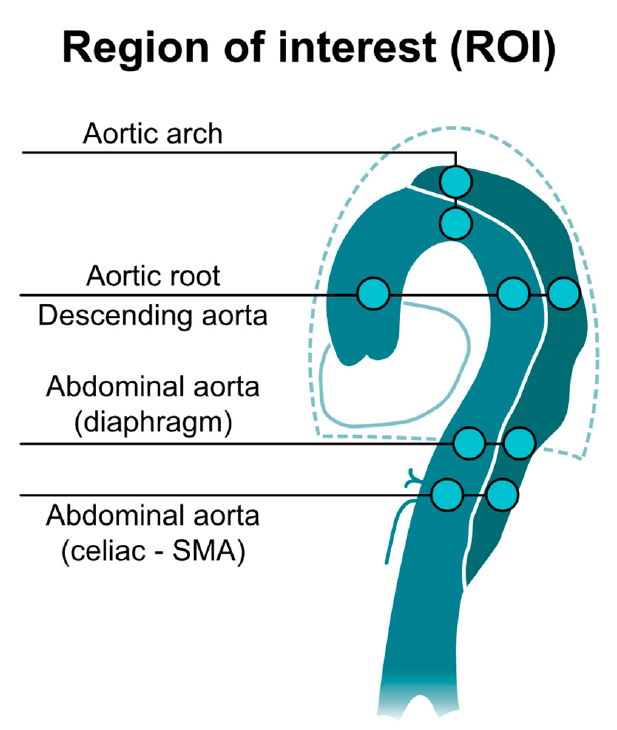
Figure 1. Illustration of QFlow scanning and drawing the region of interest (ROI). The QFlow scanning is performed at four levels to obtain two-dimensional images (perpendicular to blood flow and aortic curve). By drawing ROI on the vascular lumens (completely covering the true lumen and false lumen), eight hemodynamic variables can be obtained for each ROI for the subsequent statistical analysis. The flow direction to the head was set as positive flow.